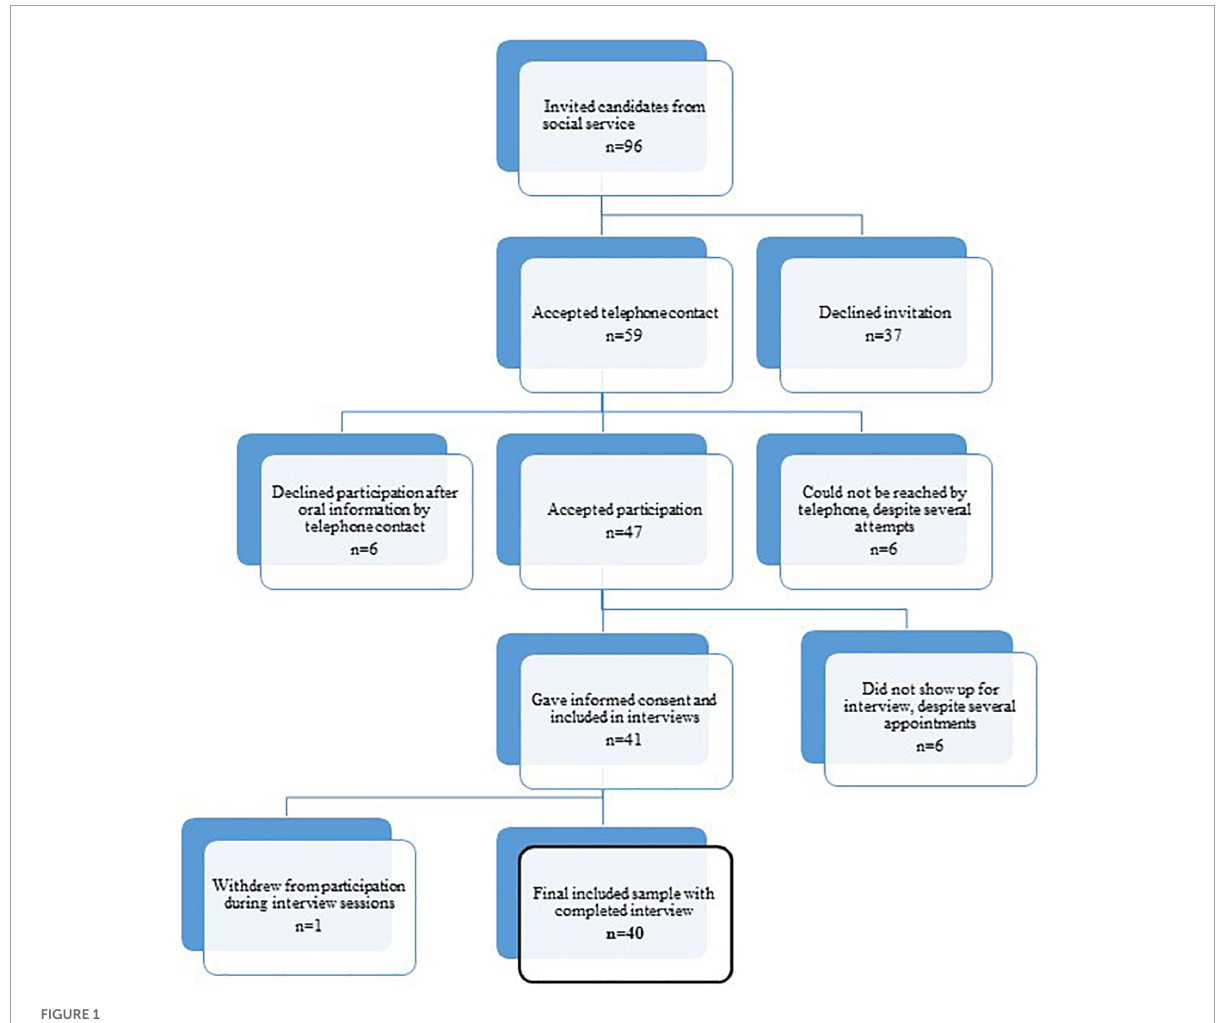
FIGURE1 Flow of study